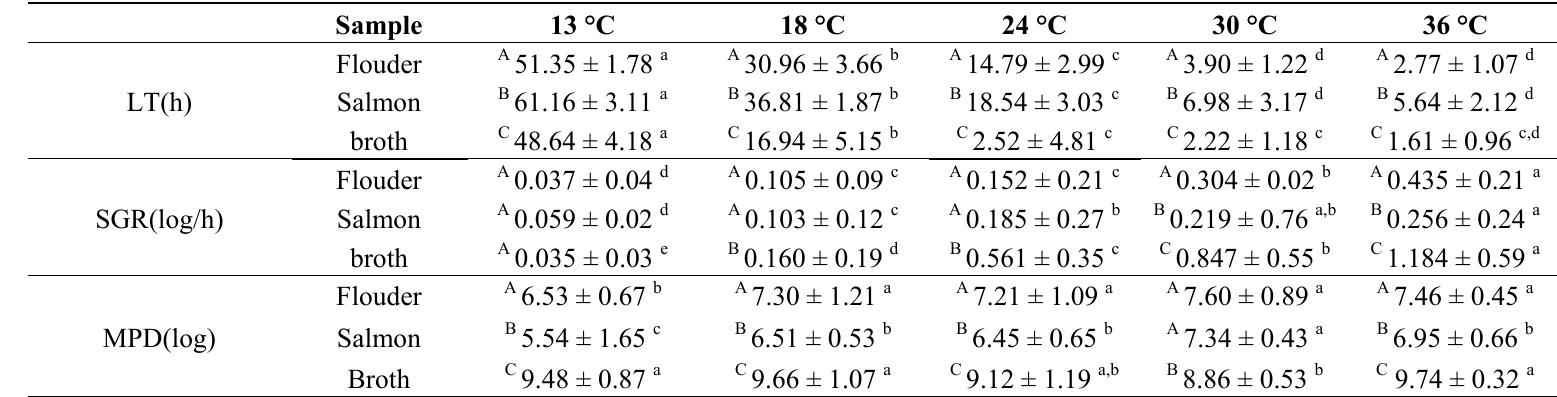
Table 3. Effect of temperature on Lag time (LT) and specific growth rate (SGR) of V. parahaemolyticus in flounder and salmon sashimi and